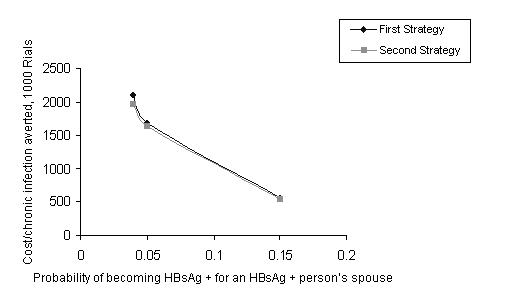
Changing the probability of becoming HBsAg positive for an HBsAg positive person's spouse (P3) after marriage from minimum to maximum varied the cost per HBV chronic infection averted from 2094370 Rials (252 $) to 558,500 Rials (67 $) in strategy 1 and from 2,041,500 Rials (246 $) to 544,400 Rials (66 $) in strategy 2. It shows that higher spouse-to-spouse transmission rates significantly increase the cost of both strategies.